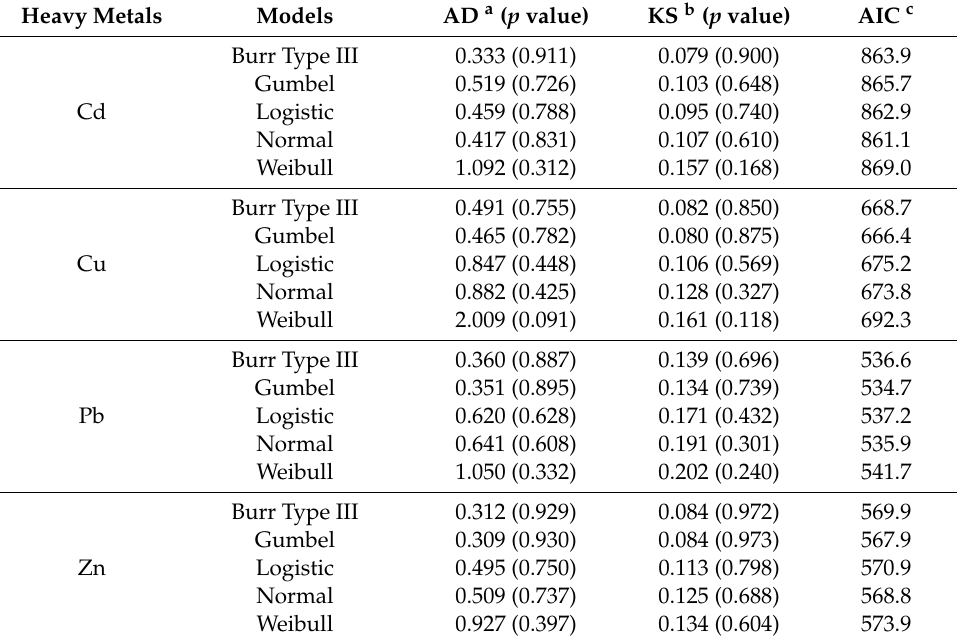
Table 5. Goodness-of-fit and information criteria of the SSD models for the four